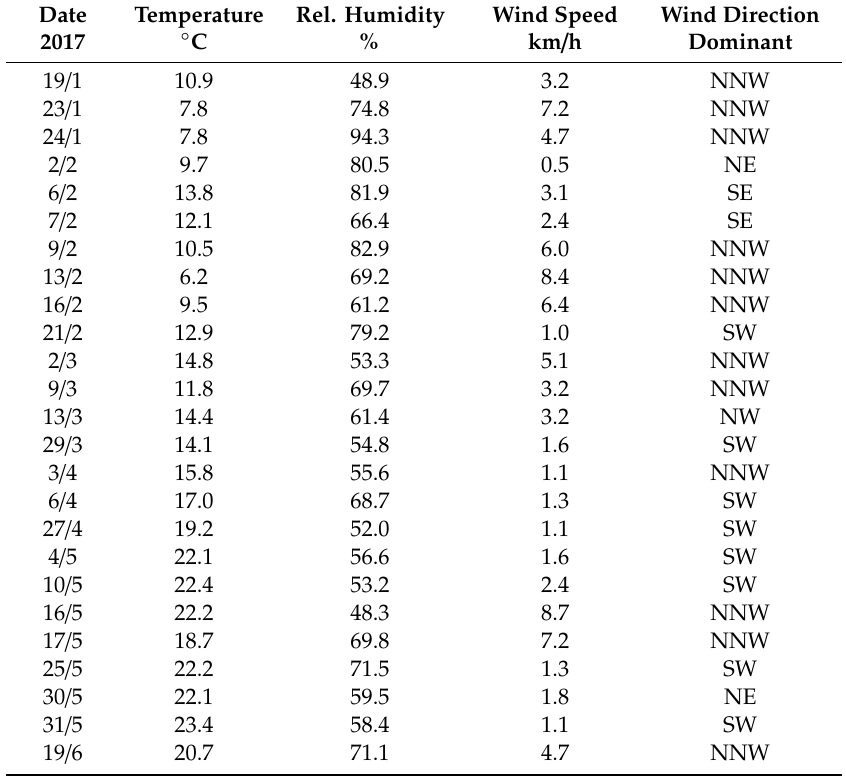
Table 1. Mean daily values of examined meteorological parameters for all experimental